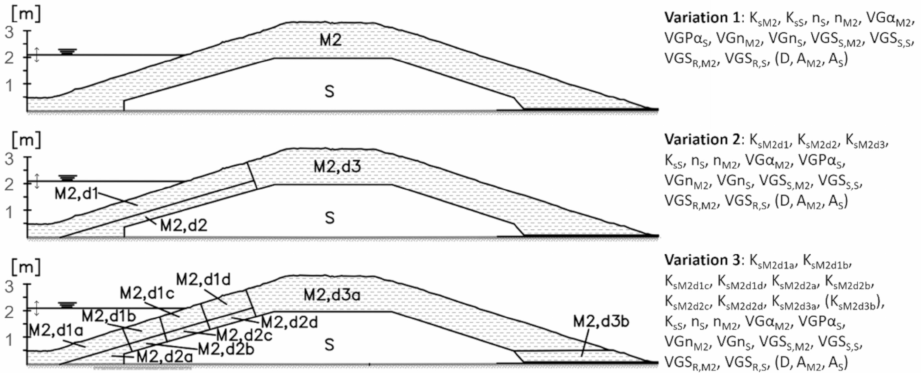
Figure 5. Applied model variations with model sections of the cover layer and respective